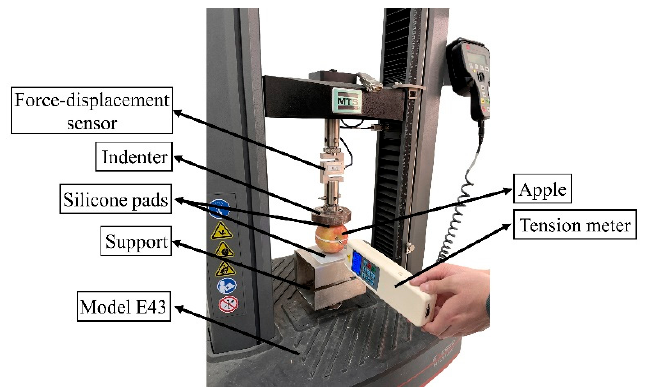
Figure 15. Diagram of mechanical properties test device.